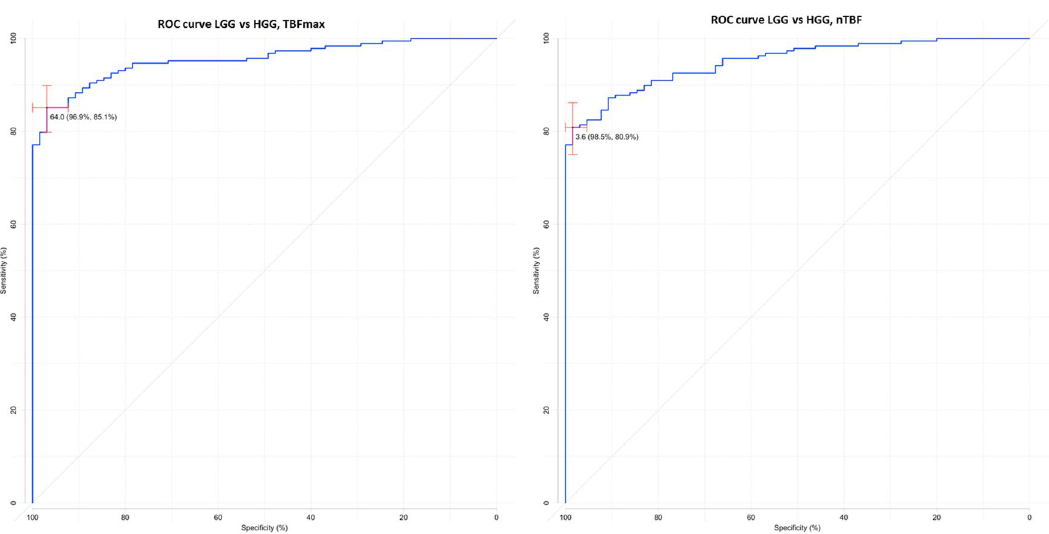
Figure 1. ROC-curve. Comparisons of maxTBF ( a ) and nTBF ( b ) in HGGs and